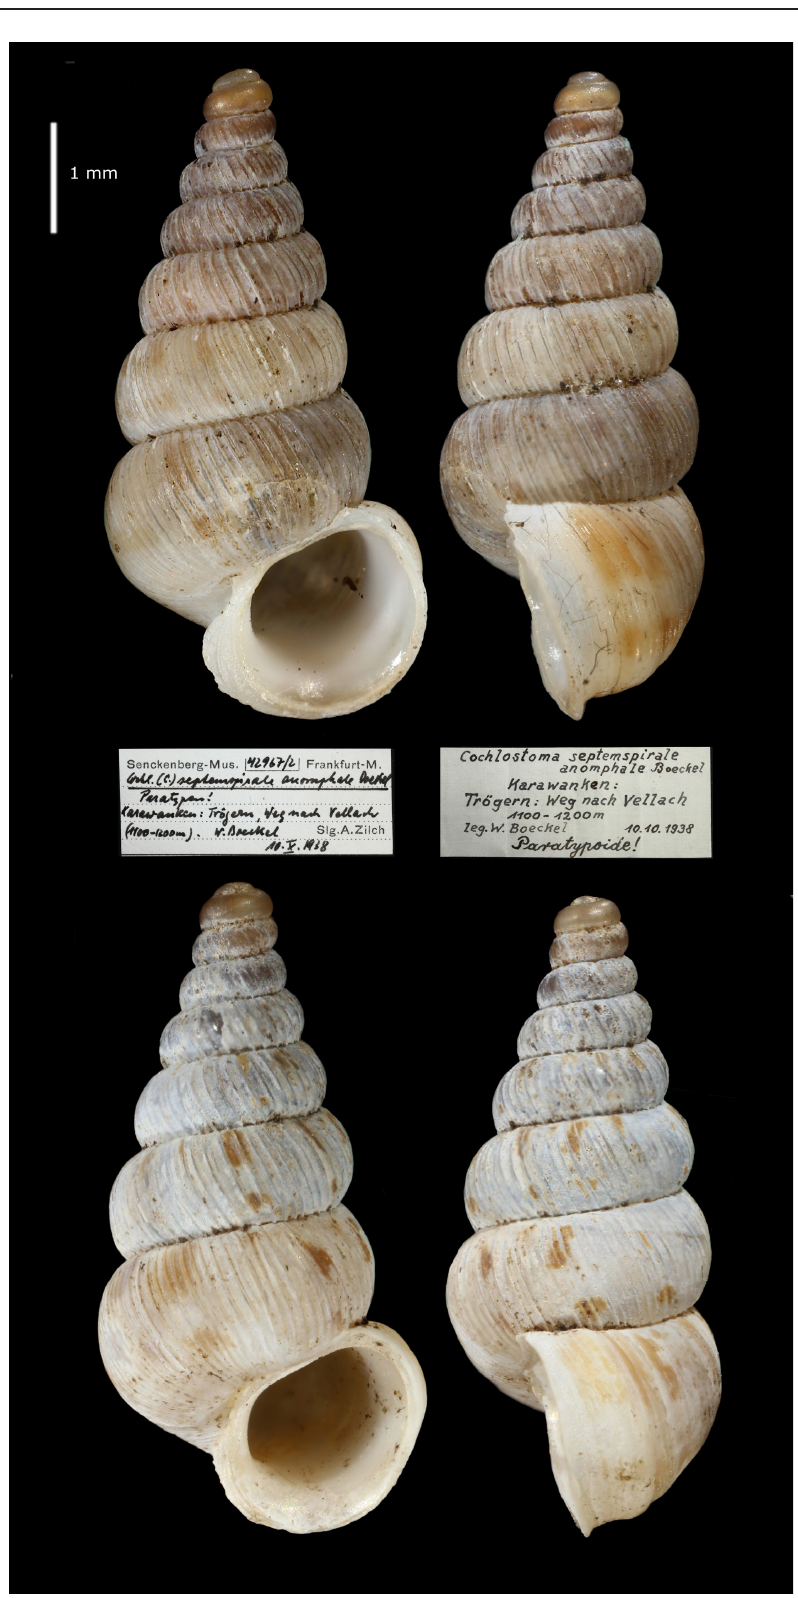
Fig. 24. Cochlostoma ( Clessiniella ) anomphale Boeckel, 1939. Paratypes at the Senckenberg Museum Frankfurt